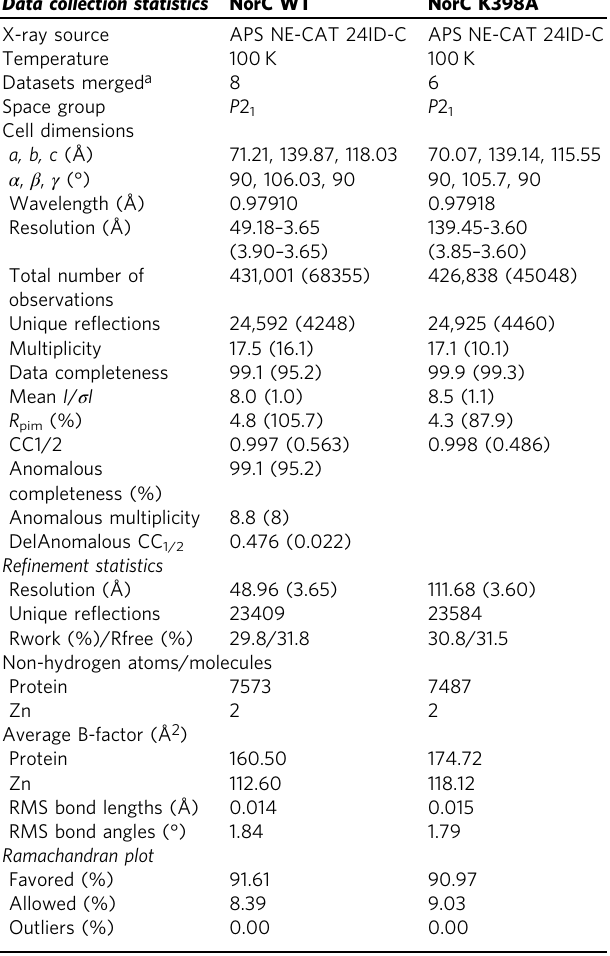
Table 1 Crystallographic data and re fi nement